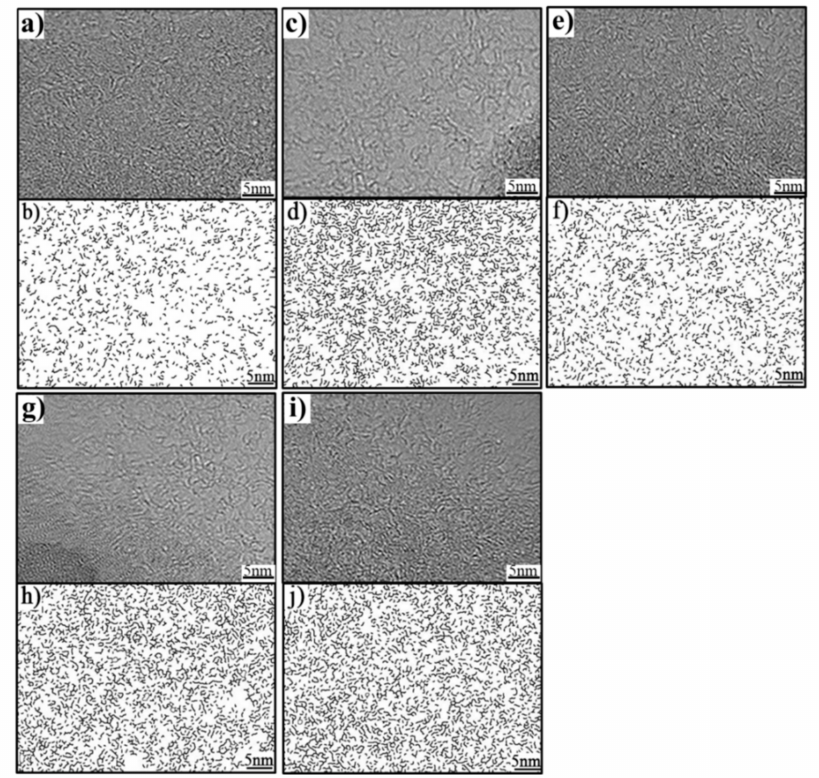
Figure 4. High-resolution transmission electron microscopy (HRTEM) images and the corresponding extracted lattice fringe images of coal and semi-coke samples: ( a , b ) raw coal; ( c , d ) C450; ( e , f ) C450M; ( g , h ) C750; ( i , j ) C750M. Table 4. Aromatic fringe assignments and distribution frequency based on the analysis of HRTEM fringe